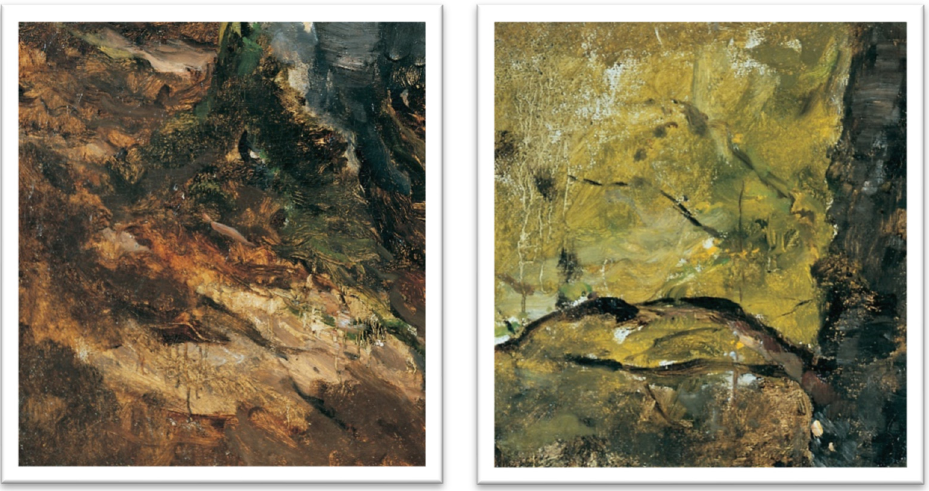
Figure 11. Frank Duveneck, Beechwoods at Polling, Bavaria [detail], © Cincinnati Art Museum/Gift of the Artist/Bridgeman Images.